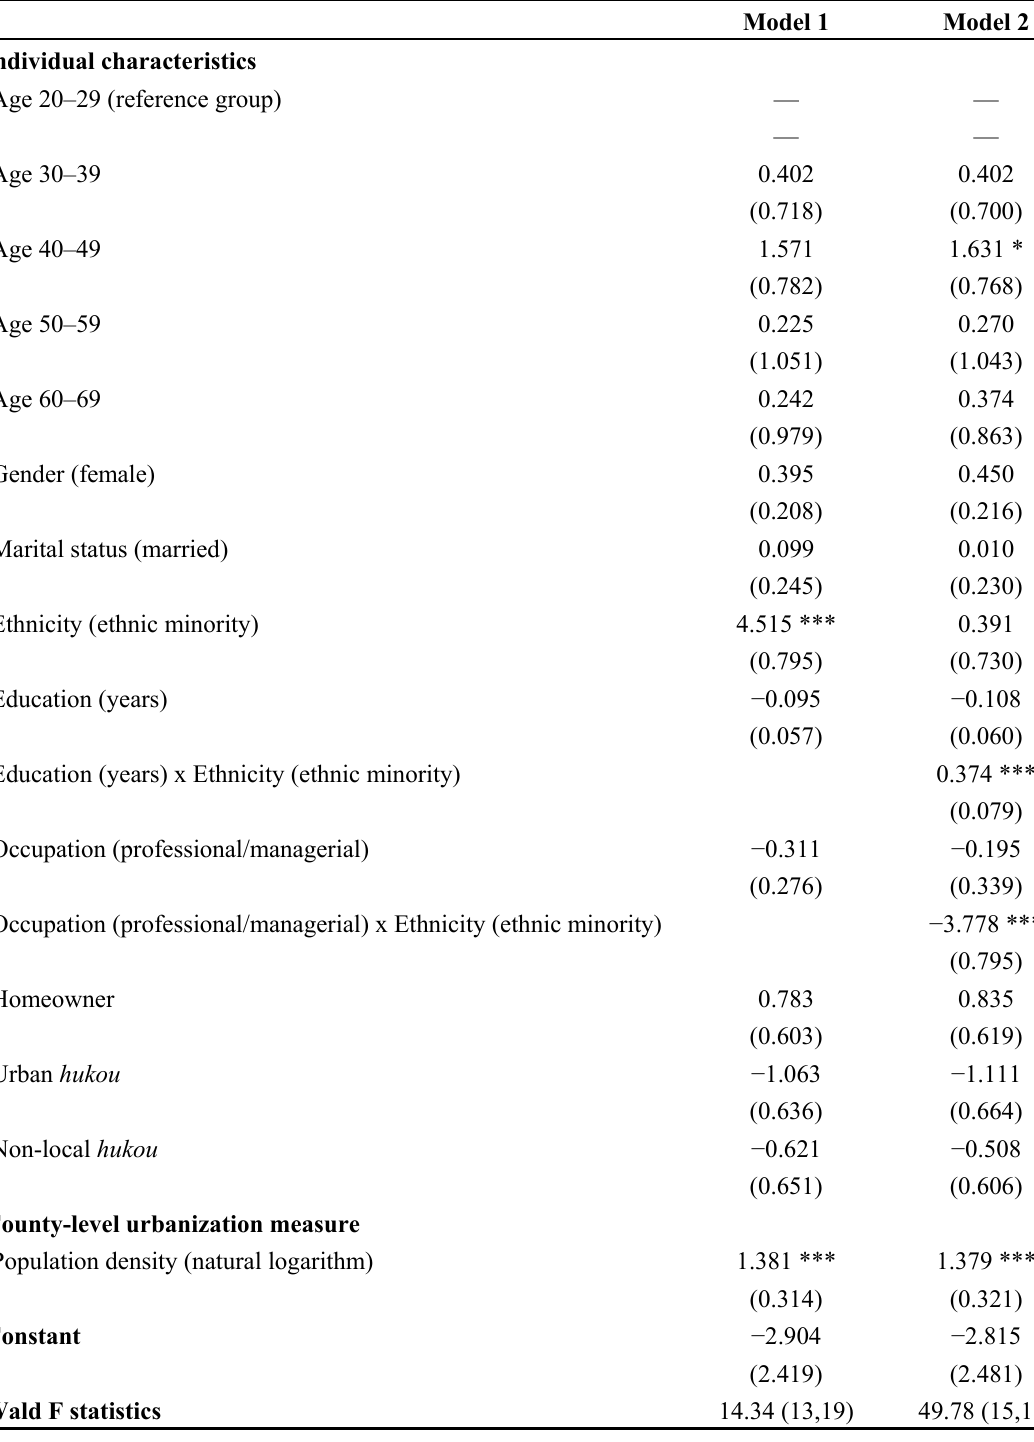
Table 2. Ordinary least square (OLS) regression estimation of individual Center of Epidemiological Studies Depression Scale (CES-D) scores ( n =